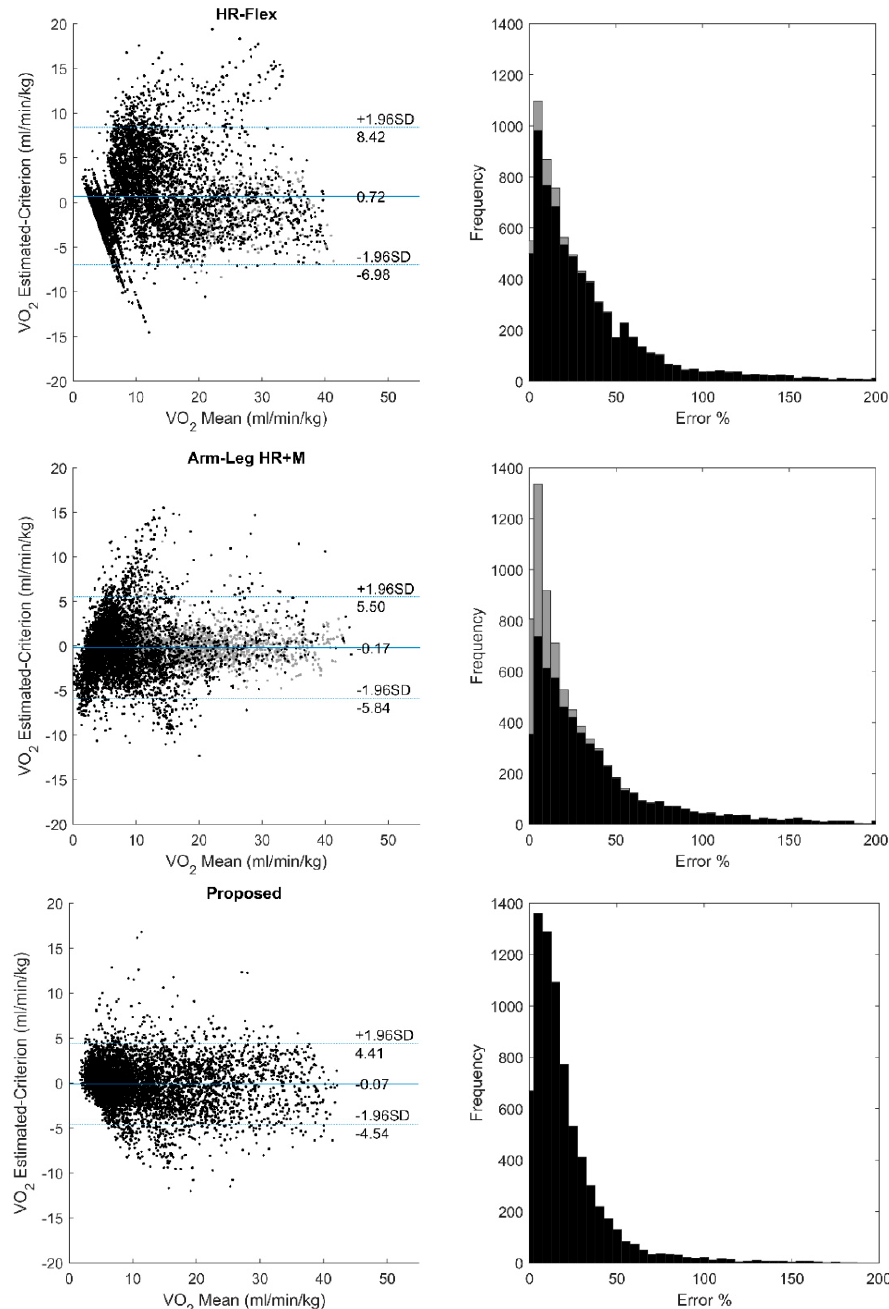
Figure 3. Bland-Altman plots and error rate histograms of flex-HR, arm-leg HR+M, and proposed methods against the criterion measurement. Data used in individual calibration are plotted in grey.